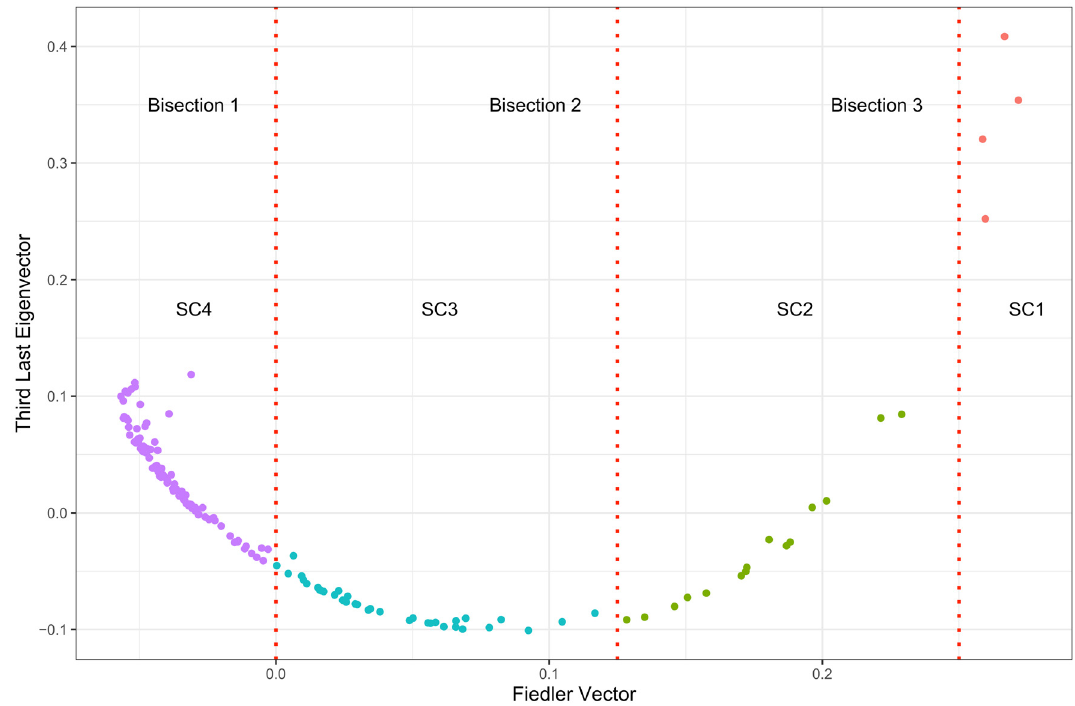
Figure 7. Natural clusters from bisections of the Fiedler vector.